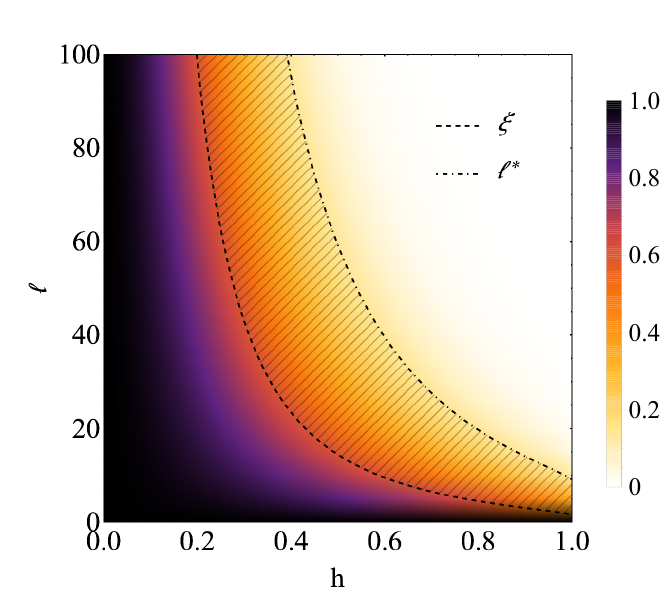
Figure 8: Density plot of the leading contribution to the ground-state overlap ζ 2 (cid:96) for different sizes and values of the magnetic field. The grey-dashed-shaded 0 area between the correlation length ξ ( c.f. Eq. (90)) and the threshold length (cid:96) ∗ = − 1 / log ζ represents the crossover region wherein the initial long-range or- 0 der and the Gaussian restoration compete so that the stationary PDF may be well approximated by Eq.